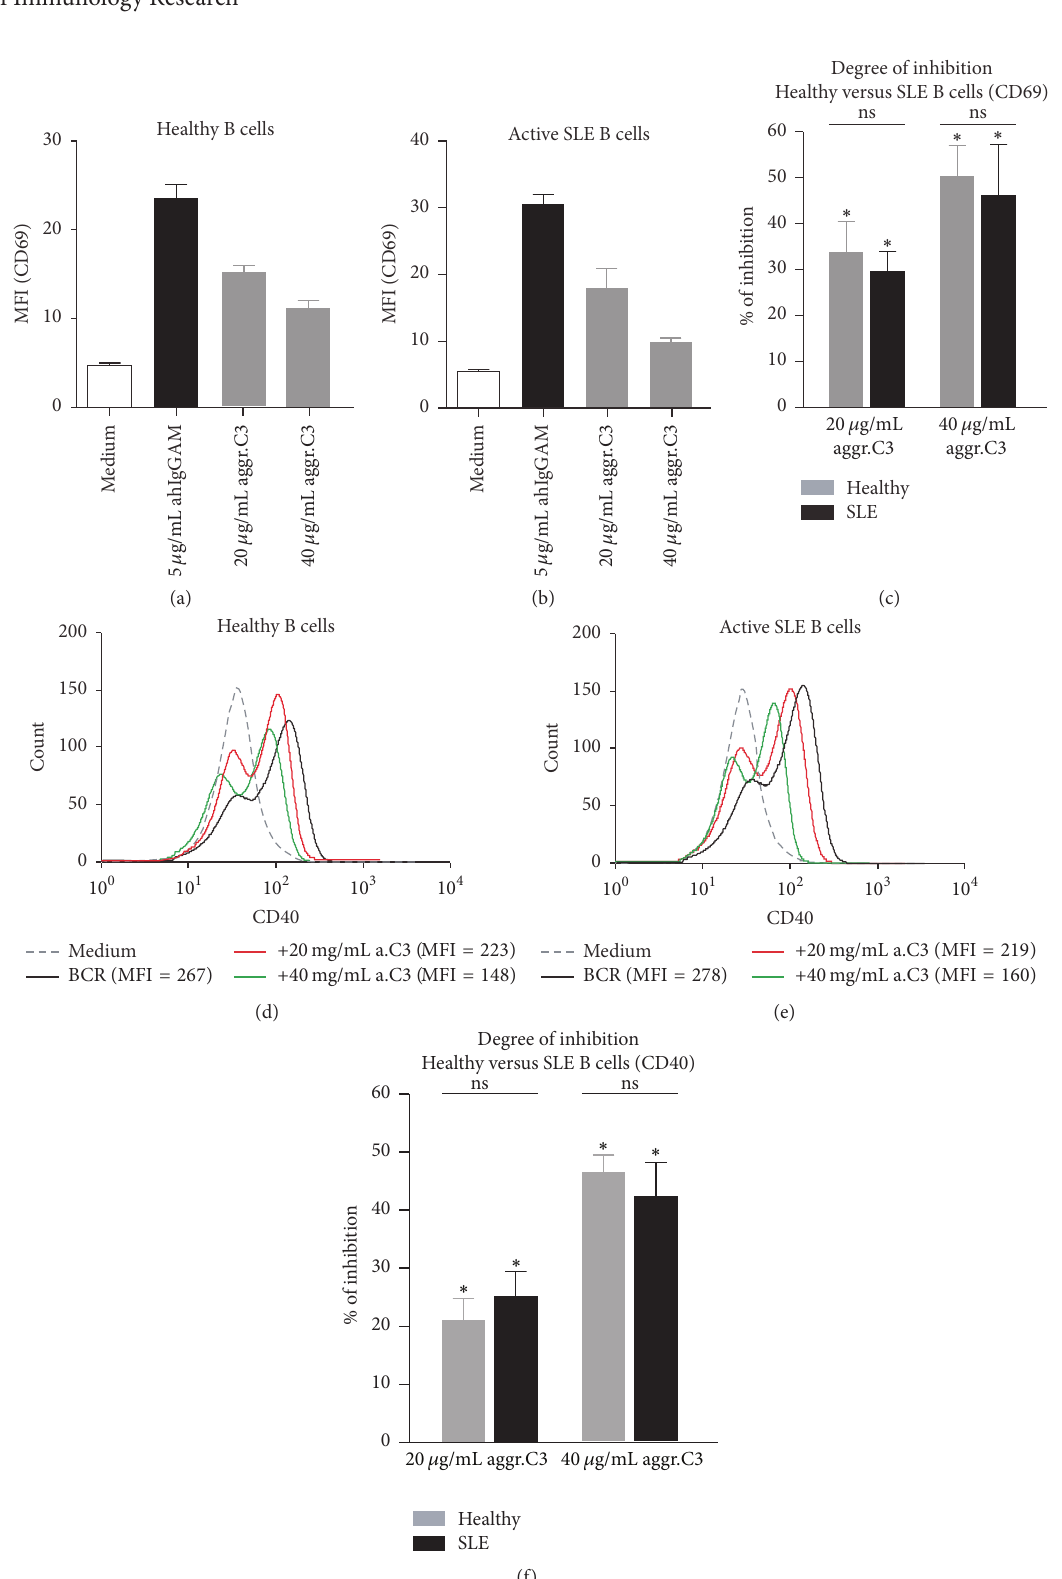
Figure 2: Effect of CR1 clustering on BCR-induced upregulation of activation markers in healthy controls and active SLE patients. 2 × 10 5 B cells isolated from healthy donors (a and b) or active SLE patients (d and e) were activated for 48 hours with 5 𝜇 g/mL F(ab’) 2 fragment of anti- human IgG+M+A in the presence or absence of different concentrations of heat-aggregated C3. As control, cells were left untreated. Results shown are either flow cytometric histograms or mean ± SD geometric mean fluorescence intensity (gMFI) of duplicate cultures of CD69 (a and b) and CD40 (d and e) expression and are representative of nine (healthy controls) or five (SLE patients) independent experiments. (c and f) Results showing percent of inhibition are mean % of inhibition ± SEM of nine (healthy controls) or five (SLE patients) independent experiments and correlated with the CR1-agonist untreated sample (see Section 2, Permutation-test; ∗ 𝑃 < 0.05 and ns 𝑃 > 0.05